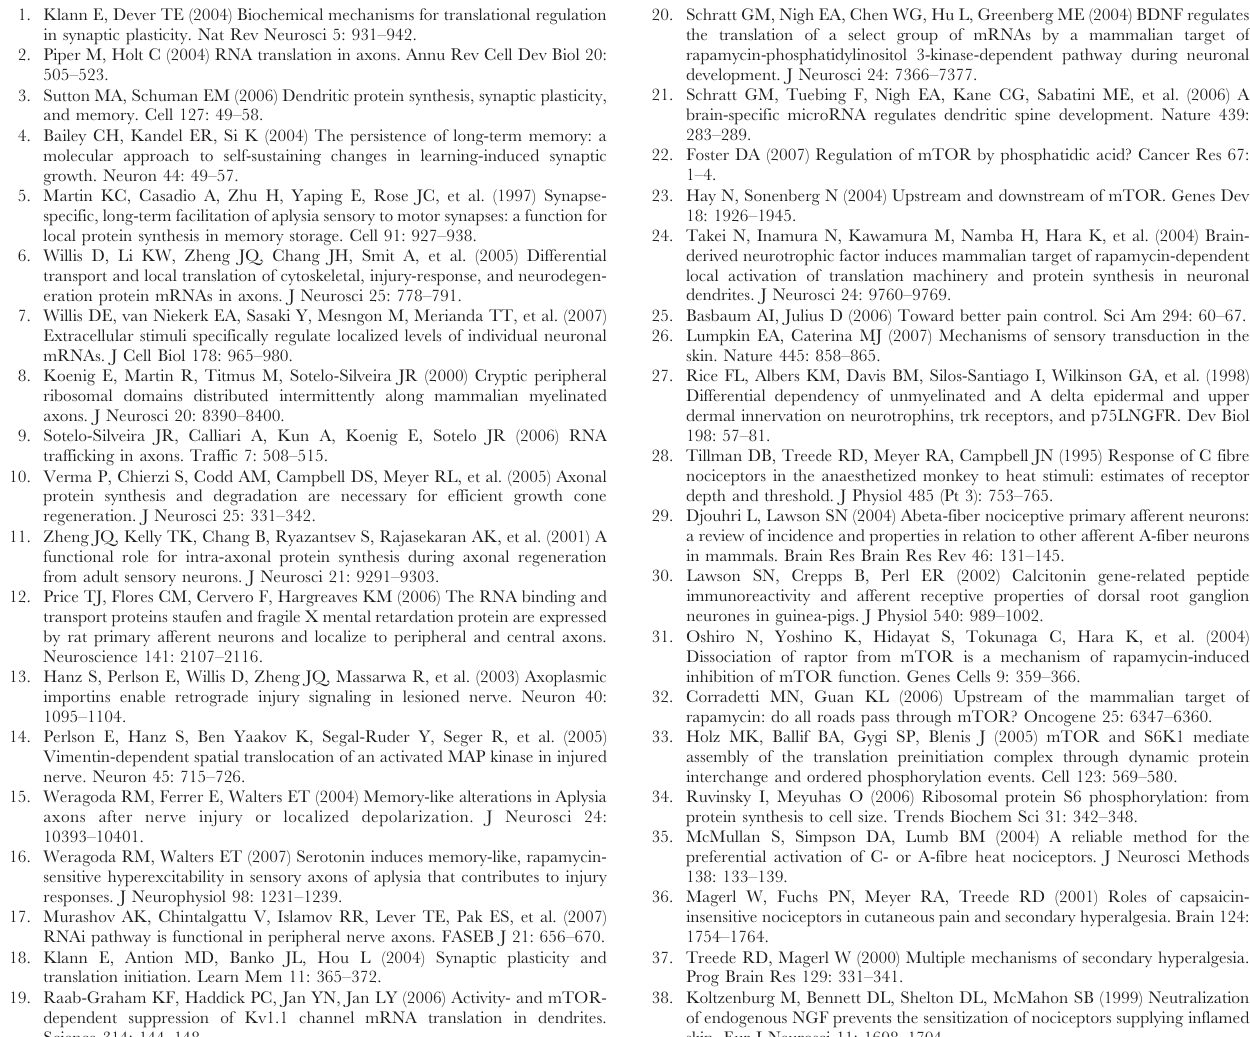
Figure S6 Dotplots showing Von Frey thresholds for mechano- sensitive AM- and C- fibers. Data have been normalized by logarithmic (ln) transformation. Vertical bars represent the geometric mean. Rap, Rapamycin; Veh, vehicle. Found at: doi:10.1371/journal.pone.0001961.s009 (1.81 MB